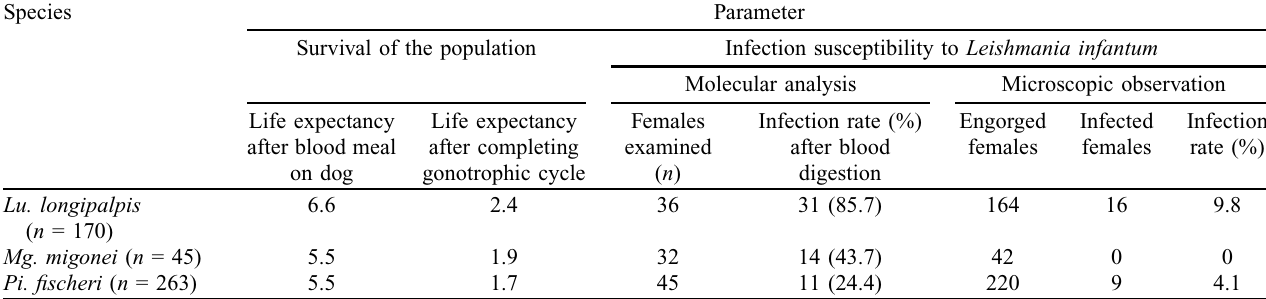
Table 3. Life expectancy and susceptibility to infection with Leishmania infantum of Lutzomyia longipalpis , Pintomyia fischeri , and Migonemyia migonei under laboratory